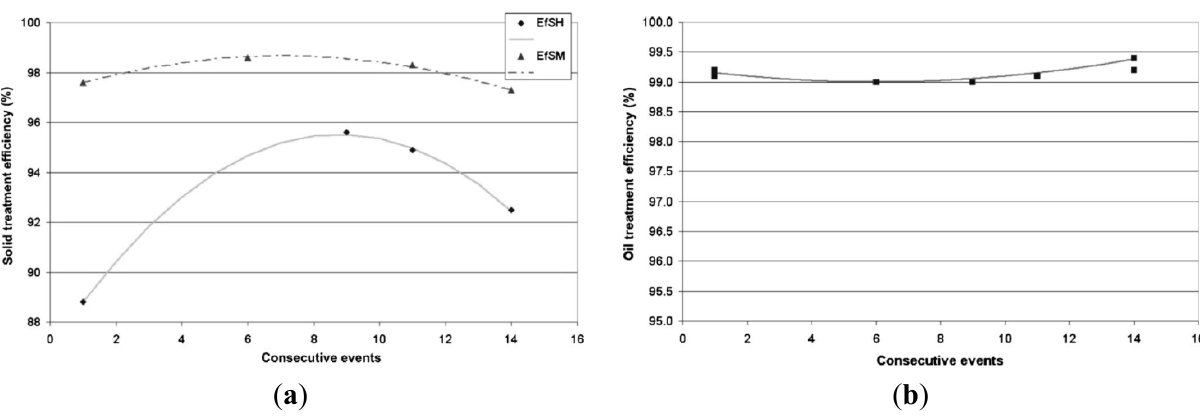
Figure 8. Pollutants reduction obtained with SCPT [57]. ( a ) Solids reduction: EfSH-High Load Conditions and EfSM-Medium Load Conditions; ( b ) Oil